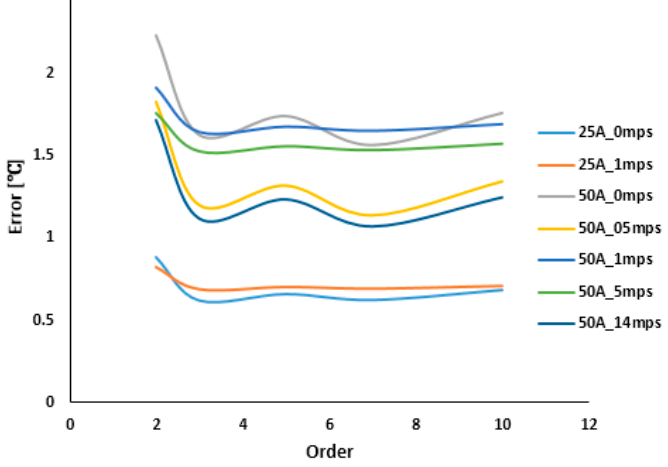
Figure 10. Maximum error vs. model order for measured Pt100 temperatures.